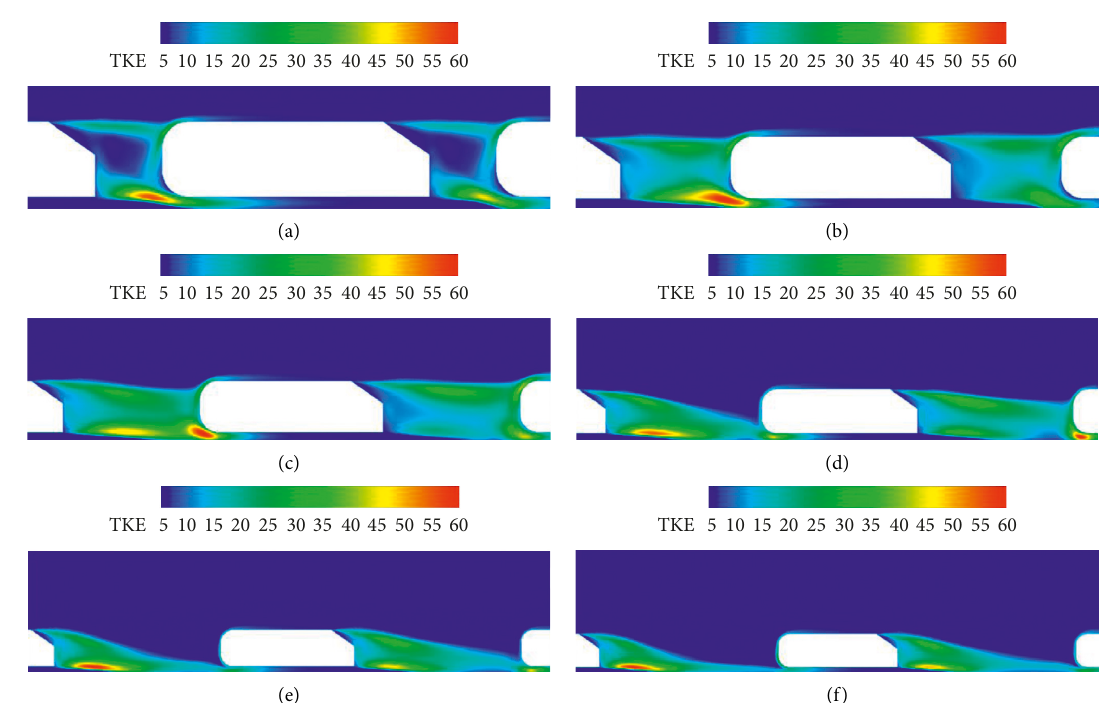
Figure 18: The distribution of TKE between three bodies at different inter-vehicle distances on the xz symmetry plane. (a) x/L � 0.25 (b) x/L � 0.5. (c) x/L � 0.75. (d) x/L � 1. (e) x/L � 1.25. (f) x/L �